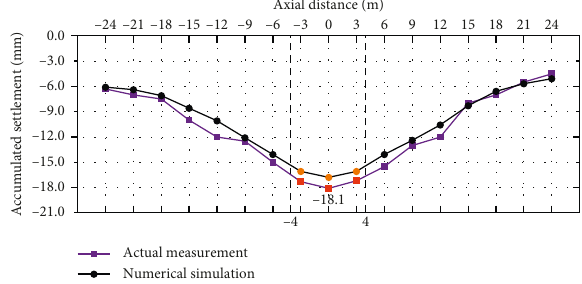
Figure 18: Cumulative settlement curve of vaults in Jia Hua Tunnel Left